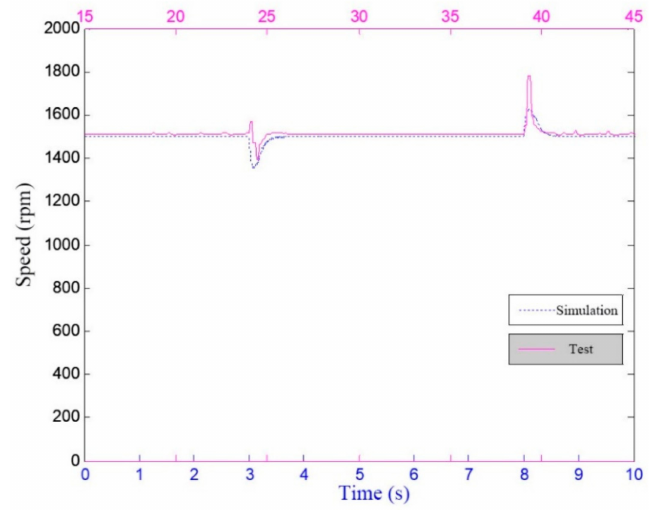
Figure 22. Comparison of rotational speeds between simulation and test.